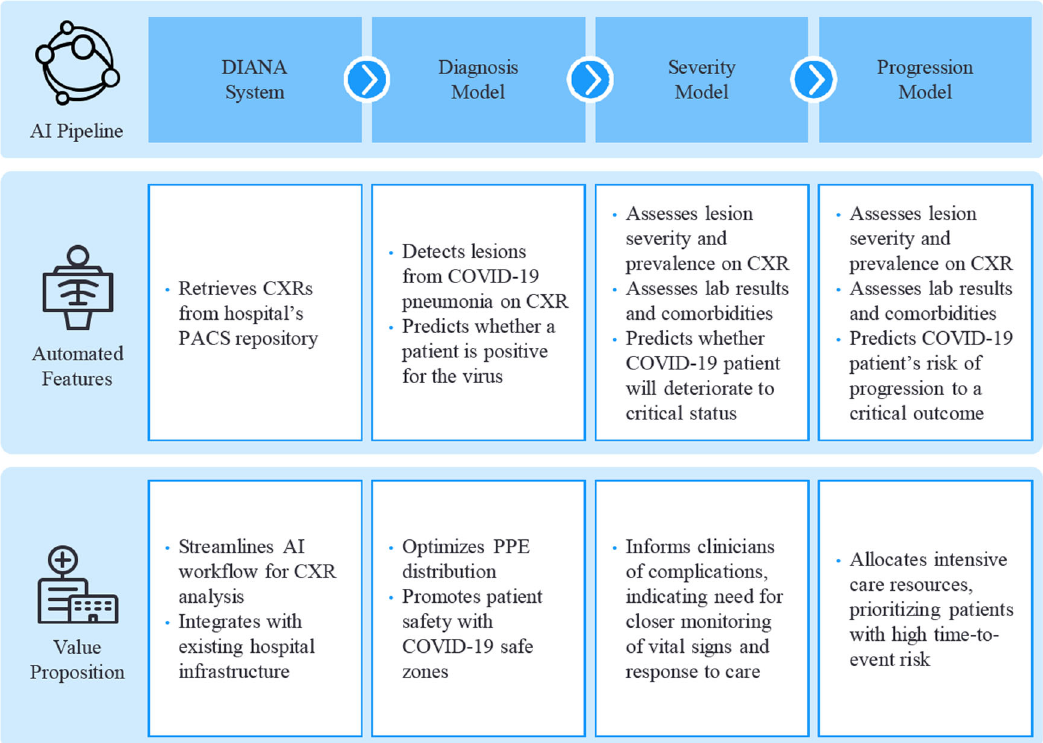
Fig. 4 Features and value propositions of individual pipeline components. The outlined components work together to deliver an end-to- end pipeline to rapidly identify and triage COVID-19 patients within an emergency department. Tangible value propositions are outlined for each